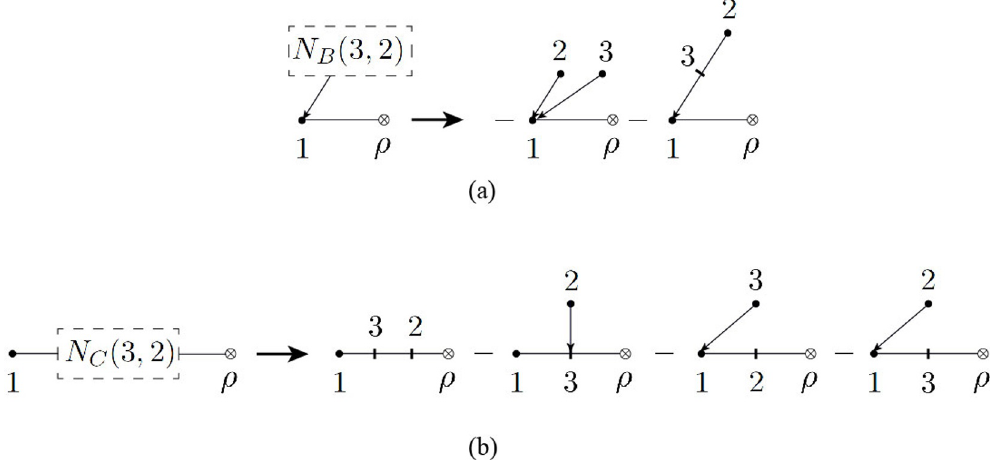
Figure 10 . Relations between the type-A graphs F ∈ G A [3 , 2] and the graphs with fewer points for the division σ = { 2 , 3 } → σ